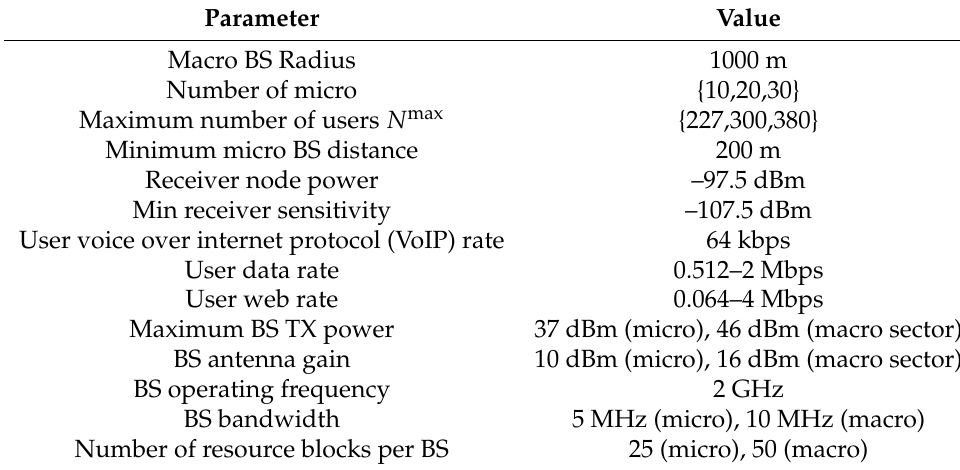
Table 4. LTE scenario